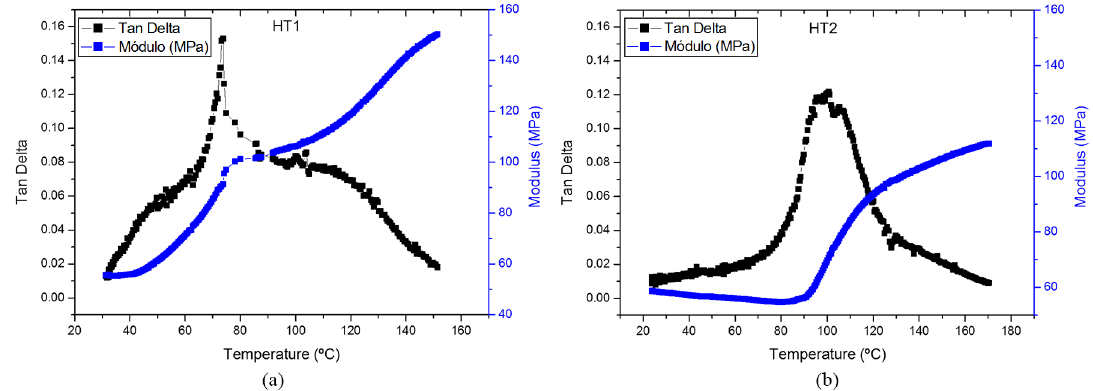
Figure 8. Internal friction tan δ and storage modulus as a function of temperature during step cooling for Ti-Ni alloy by